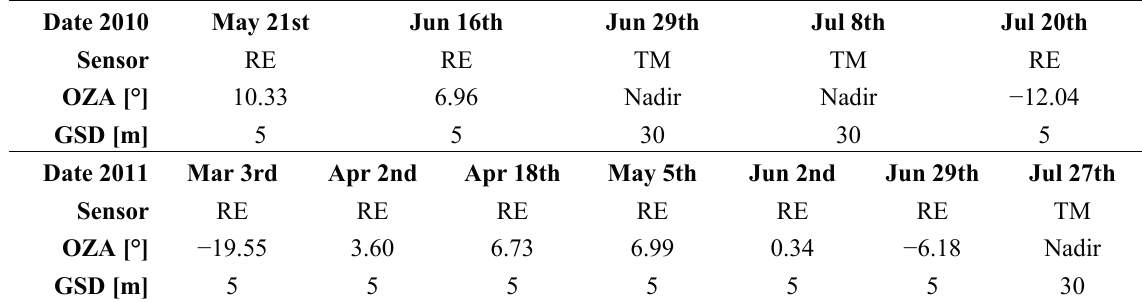
Table 5. Earth Observation data available for assimilation into the PROMET model (OZA = Observer Zenith Angle, GSD = Ground Sampling Distance, RE = RapidEye, TM = Landsat 5